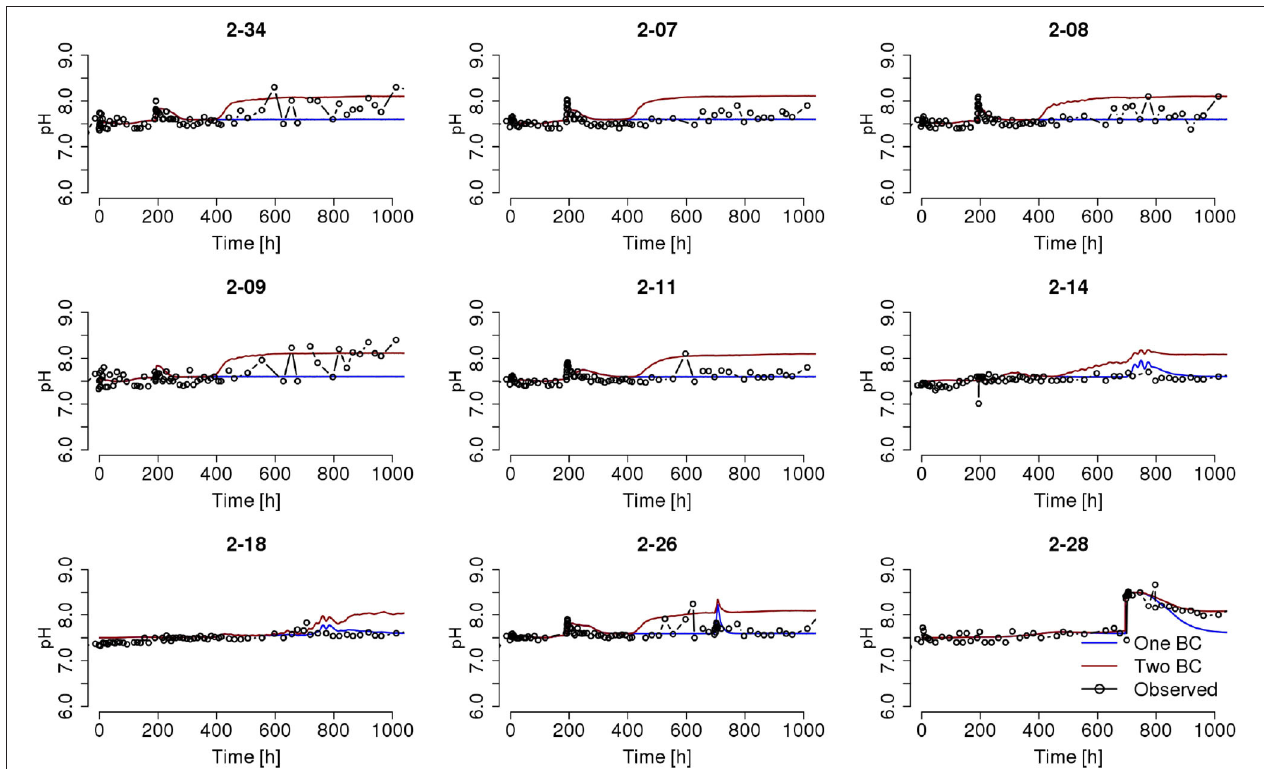
FIGURE 9 | Simulated pH time series in selected wells using two boundary configurations for pH compared to observations. The “One BC” case refers to constant pH concentrations during the simulation window, while the “Two BC” case refers to raising pH concentrations at the northern and western boundaries from 7.5 to 8.12 after 290 h from the start of the simulation. Other modeling configurations are the same as in Figure 8